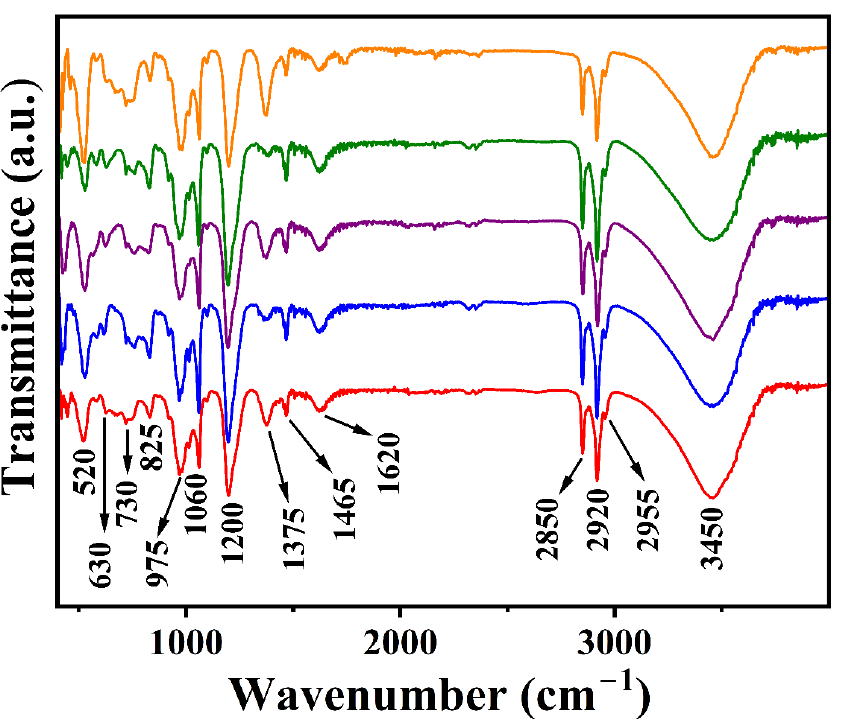
Figure 6. FTIR spectra of Li-M-Al-DS LDHs (M = Mg (data in red), Co (data in blue), Ni (data in purple), Cu (data in olive green), and Zn (data in orange)).